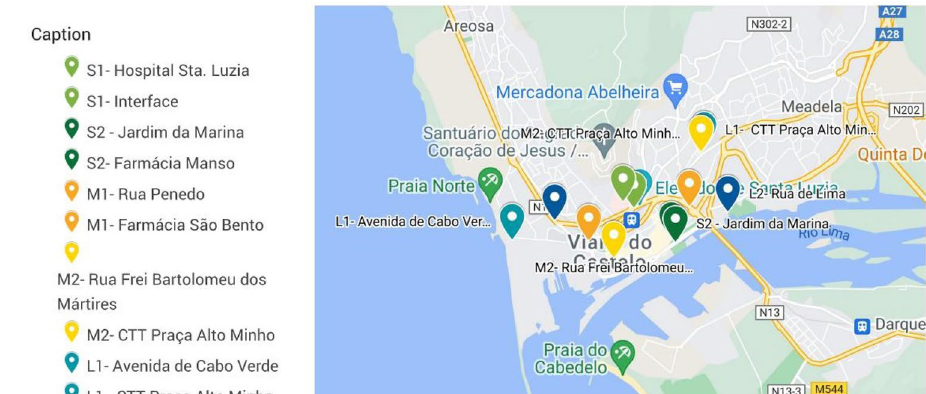
Fig. 2 Paths start and end points